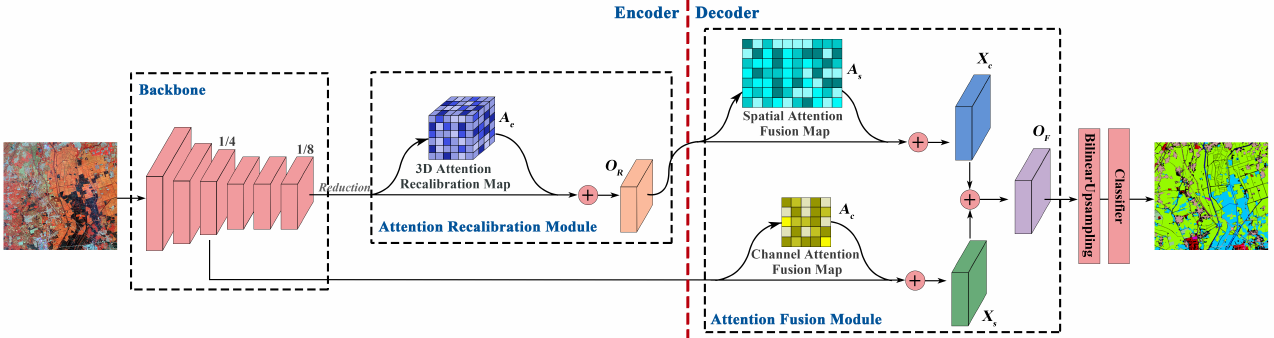
Figure 1. An overview of the XANet architecture. The high-level feature extracted by the backbone network is fed into ARM for enhancement, and then it is fused with the low-level feature via AFM to perform a better